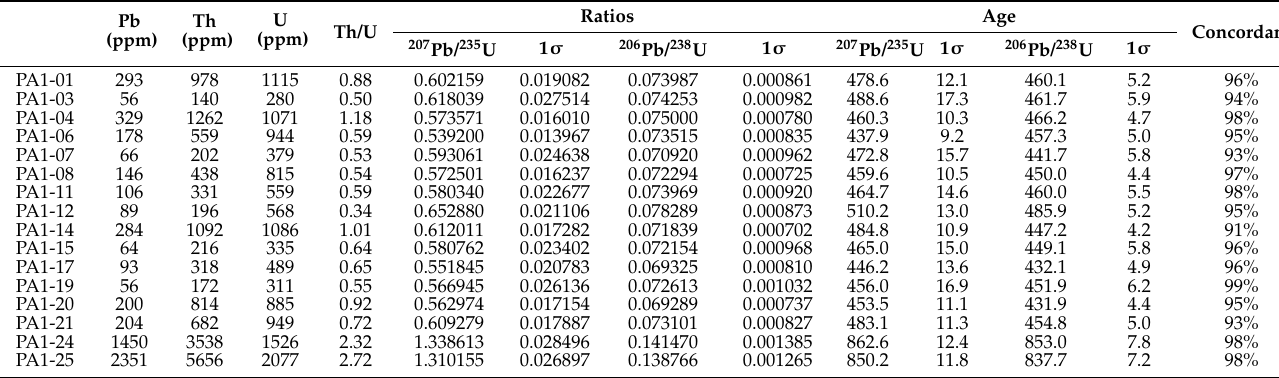
Table 2. Results of LA–ICP–MS zircon U–Pb age determinations.